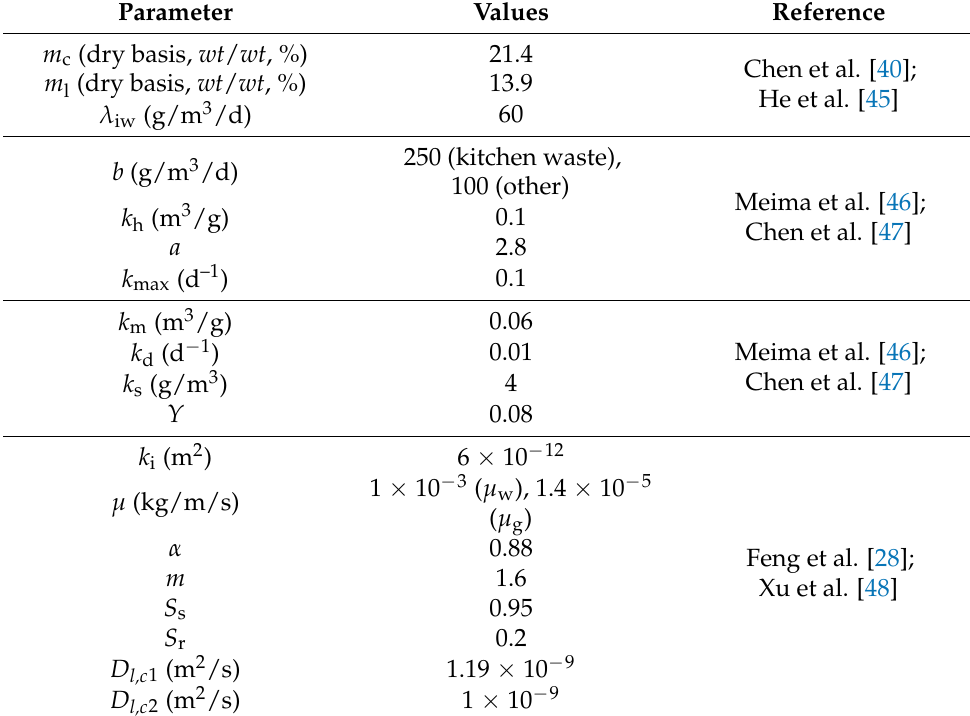
Figure 1. Hypothetical cases of bioreactor landfill cells using different leachate recirculation systems. Table 1. Parameter values of HBM-coupled model.